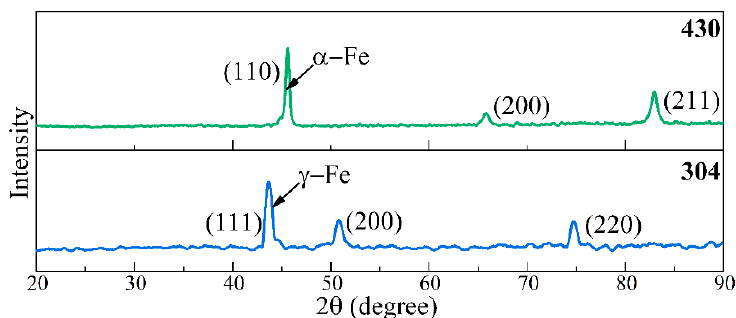
Figure 5. XRD spectrum of 304 and 430 SSFs.